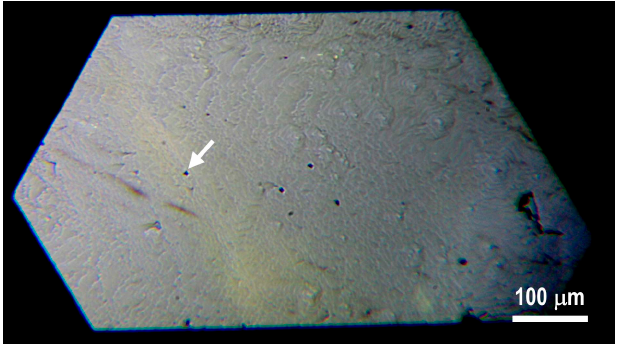
Figure 1. (111) plane of the synthetic diamond single crystal. The arrow points to the indent which was studied by AFM and micro-Raman techniques.